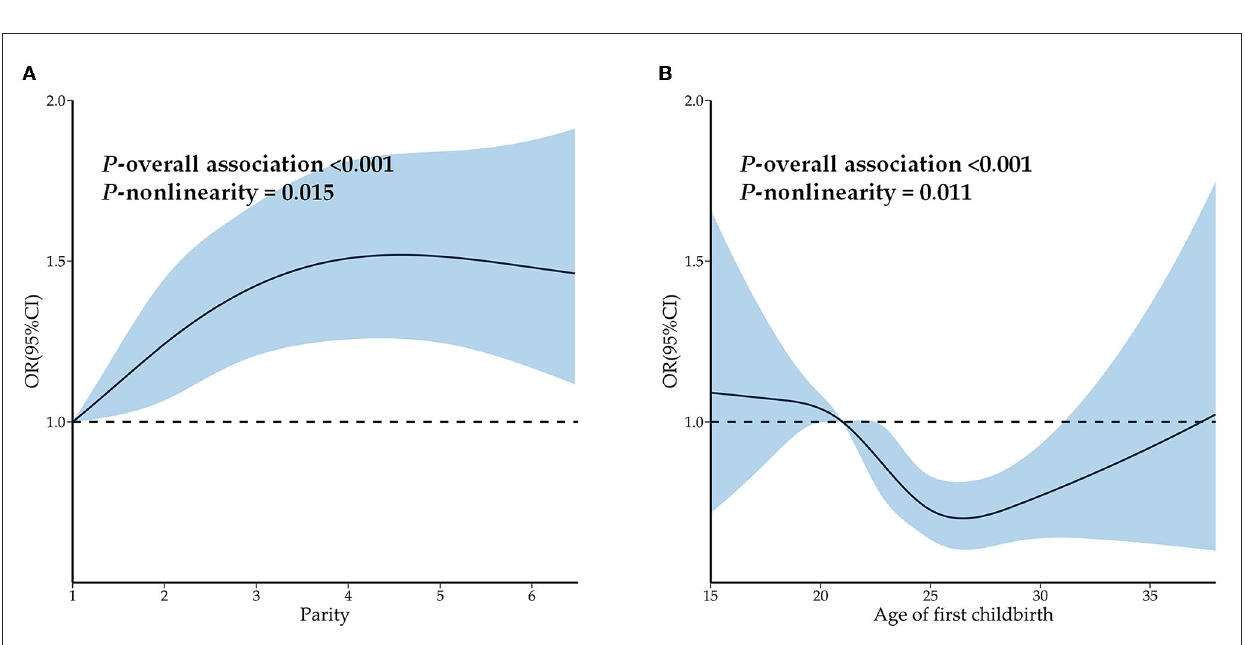
fertility is an important event in the life course of middle-aged and elderly women in China, and its effect on multimorbidity is a promising topic worth exploring. The mechanisms underlying the association between fertility and multimorbidity may be complex including direct physiological and psychological damage and indirect socioeconomic effects